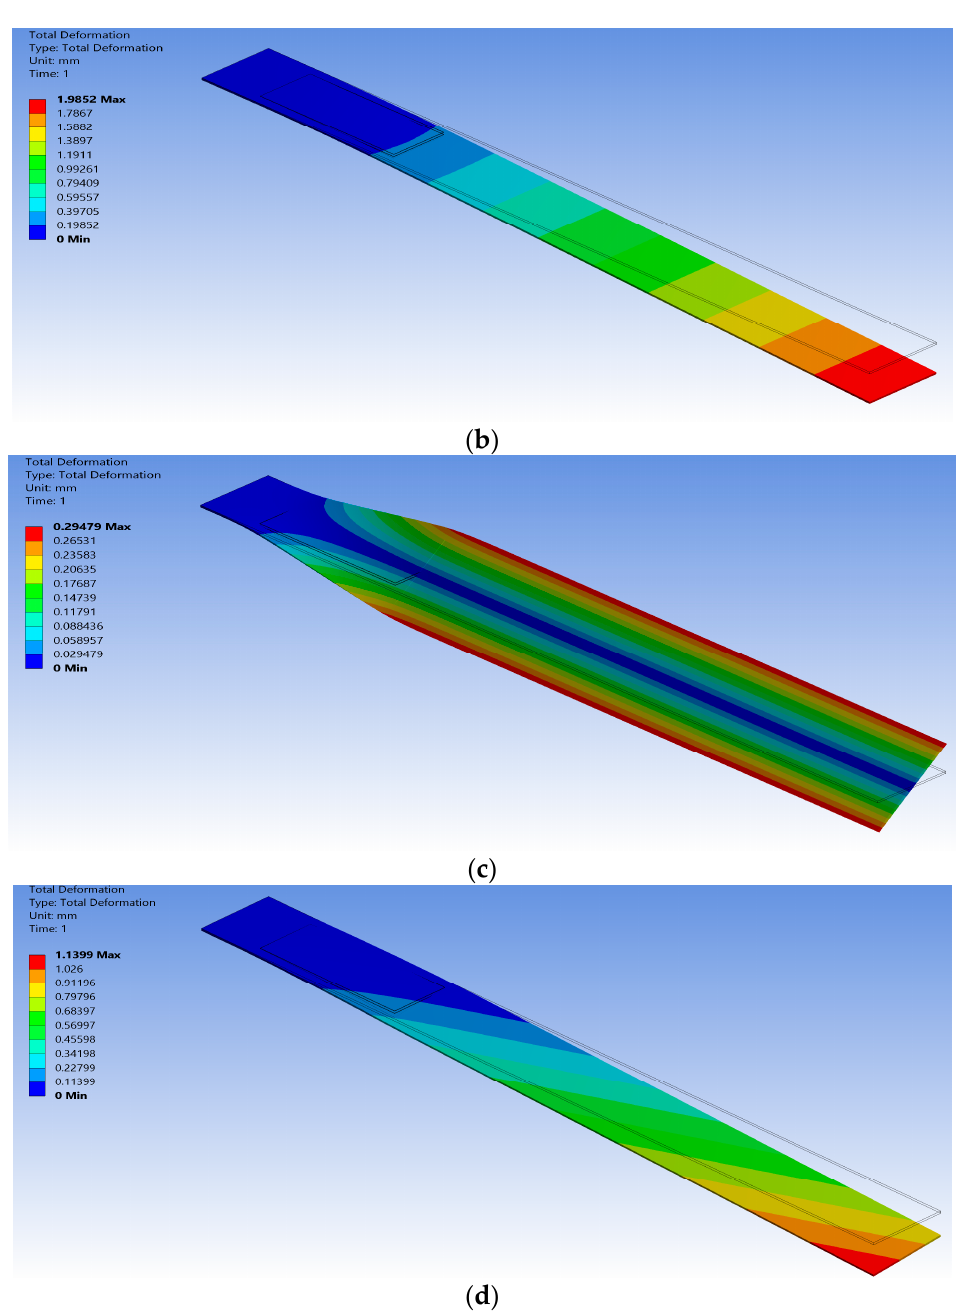
Figure 9. FE model of morphing wing with bimorph configuration of MFC actuators. ( a ) Two MFCs are bonded on the top and bottom surfaces of the cantilever beam. ( b ) The bending moment resulting from applying different voltages on MFCs. ( c ) The torsion moment resulting from applying the same voltages on MFCs. ( d ) The coupled torsional and bending moments resulting from actuating only one MFC from either side.